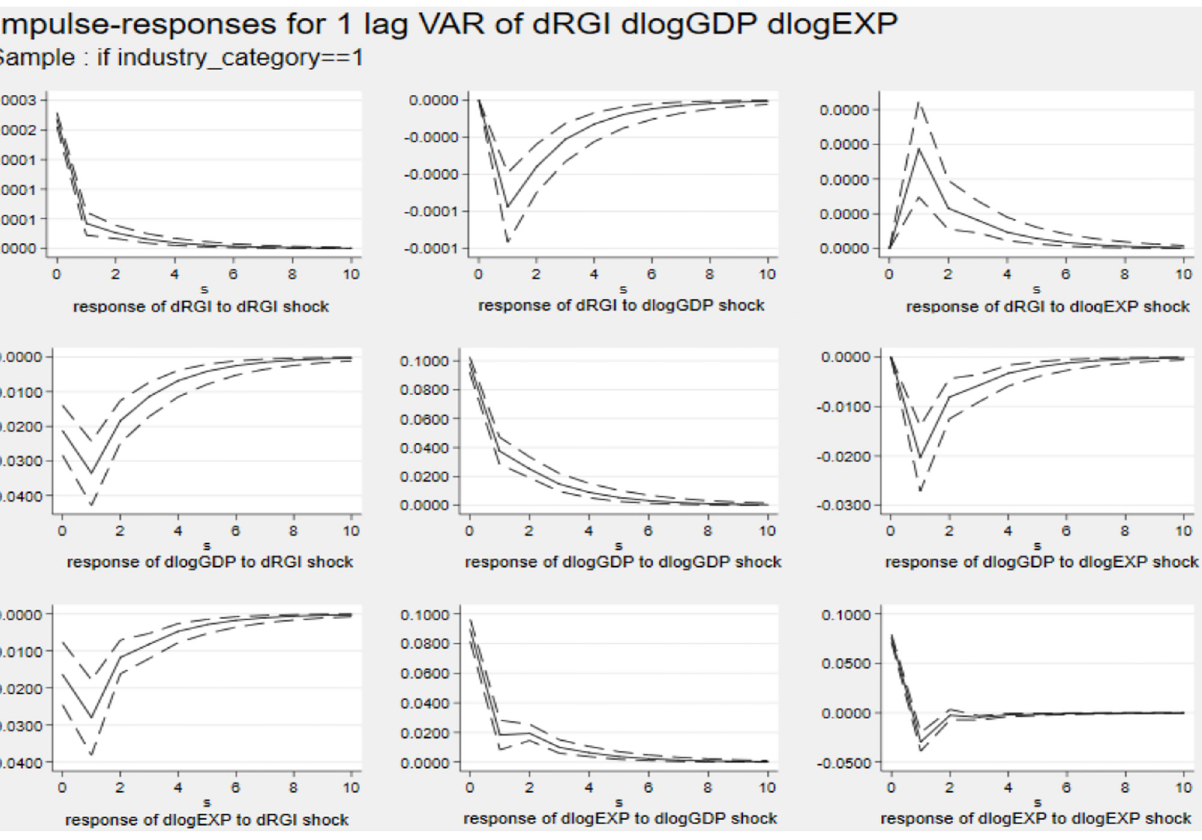
Fig 6. Impulse response diagram in Cluster 5. Notes : Errors are 5% on each side generated by Monte-Carlo with 2000 reps.